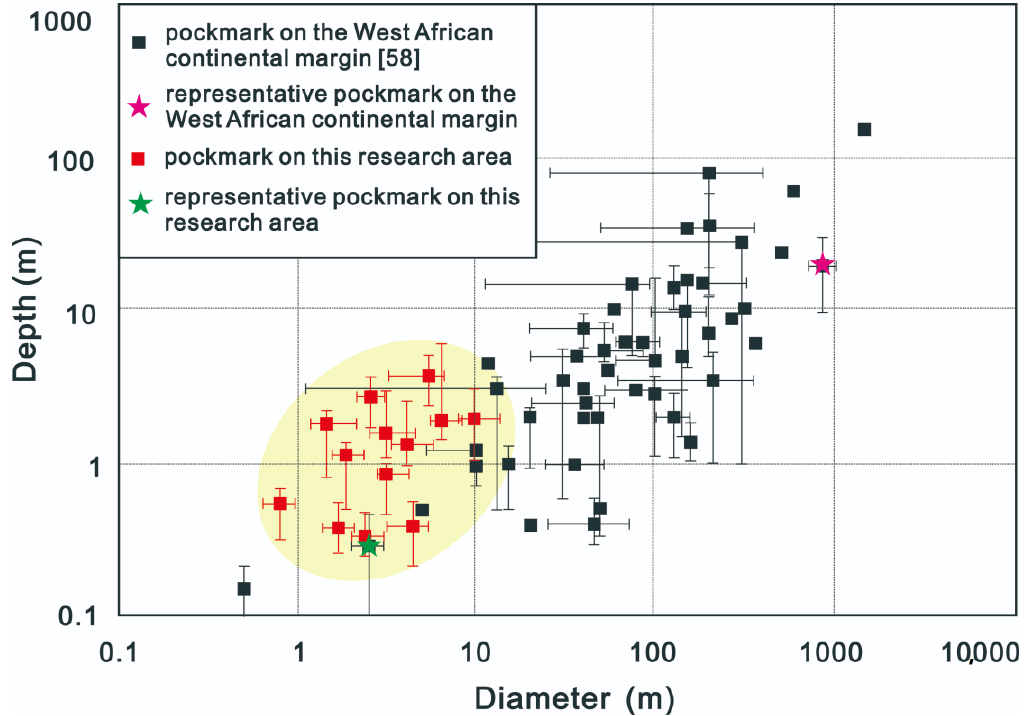
Figure 5. The relations diagram of pockmark diameter and depth. The line segment represents the variation range of the size of a single pockmark, and the point represents the size of a single pockmark area or the average value of the size of a single pockmark [58].